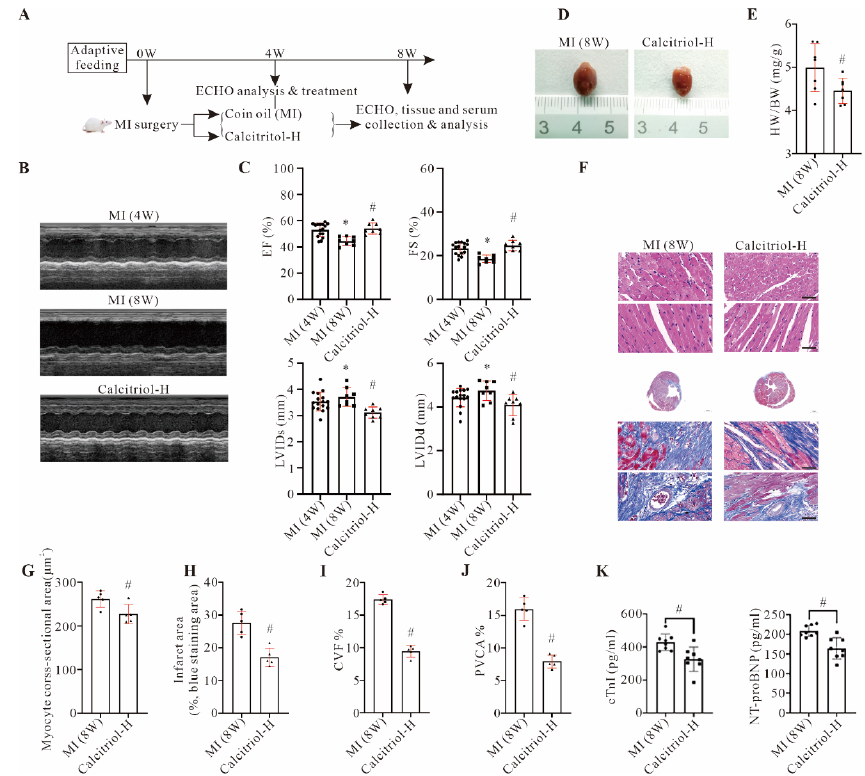
Figure 3. Calcitriol treatment in established chronic MI halted disease progression. ( A ) Experimental protocol of the therapeutic study. From week 5, mice in the MI group were further randomly divided into two treatment groups and received corn oil (MI(8W)) and high dose calcitriol (Calcitriol-H), re- spectively. ( B , C ) Cardiac function analysis by echocardiogram. ( B ) Representative echocardiography images of mice with MI surgery (MI (4W)) or MI surgery with (Calcitriol-H)) or without (MI (8W)). Calcitriol-H treatment starting from five weeks post MI. ( C ) Quantitative analysis of EF, FS, LVIDs, and LVIDd from seven mice with different treatments ( n = 7). Representative macroscopic heart images ( D ) and the ratio of HW/BW (mg/g) ( E ) were shown here. ( F – J ) HE and Masson-trichrome staining analysis. Representative images ( F ) and quantitative analysis of myocyte CSA ( G ), infarct area ( H ), CVF ( I ), and PVCA ( J ) from five mice ( n = 5) were presented here. ( K ) Serum NT-proBNP and cTnI levels in mice with the indicated treatment ( n = 8) (Scale bar represents 50 µ m. Data represent means ± S.D. * p < 0.05 versus MI (4W) group, # p < 0.05 versus MI (8W) group. Unpaired student t -test was used in ( E , G – K ), while one-way ANOVA with a post hoc test of Tukey’s analysis was used in C